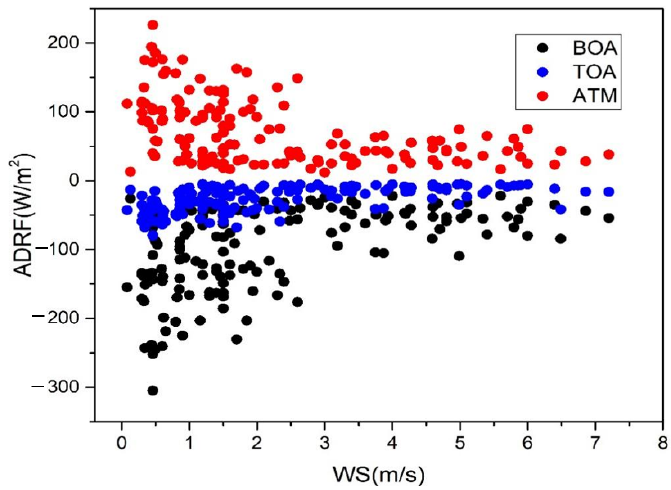
Figure 11. Correlation analysis of ADRF and WS.